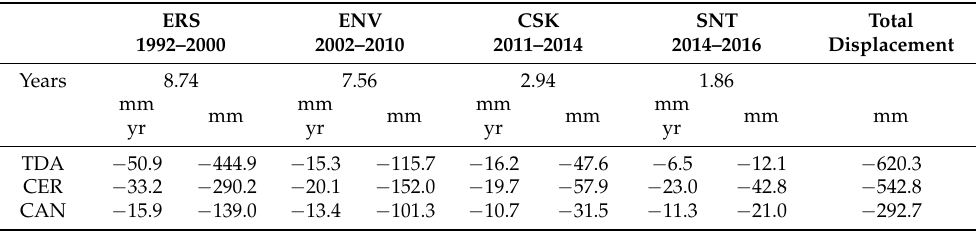
Table 4. The ground velocities and vertical ground displacements in three selected areas (CAN, CER and TDA), measured by four satellites (ERS, ENV, CSK and